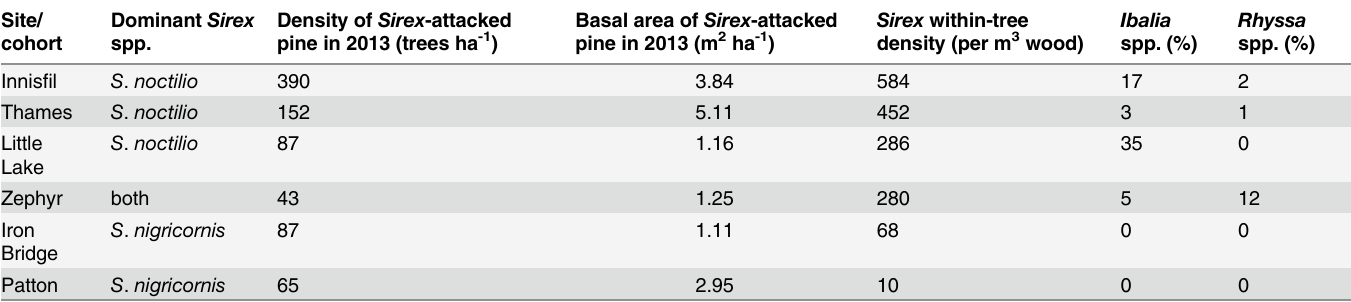
Table 1. Sirex spp. and parasitoid information at six sites throughout Ontario, from which natural life table cohorts were created.